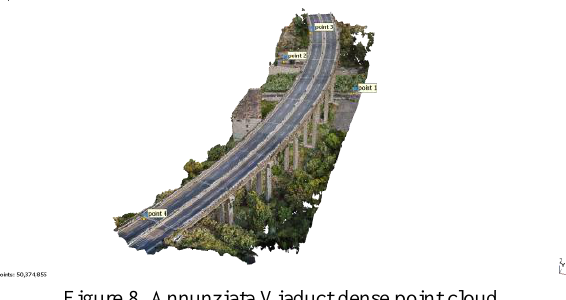
Figure 8. Annunziata Viaduct dense point cloud The automatic classification of the cloud using 2d masks, and the segmentation of the structural parts was used to extract the geometry of the Viaduct structural parts (deck, piers). On each photo the Mask RCNN algorithm is applied, to recognize target figure ( fig.8 ). While the entire structure and the deck were recognized using segmentation algorithms, the piers were reconstructed by subtracting the two created masks.